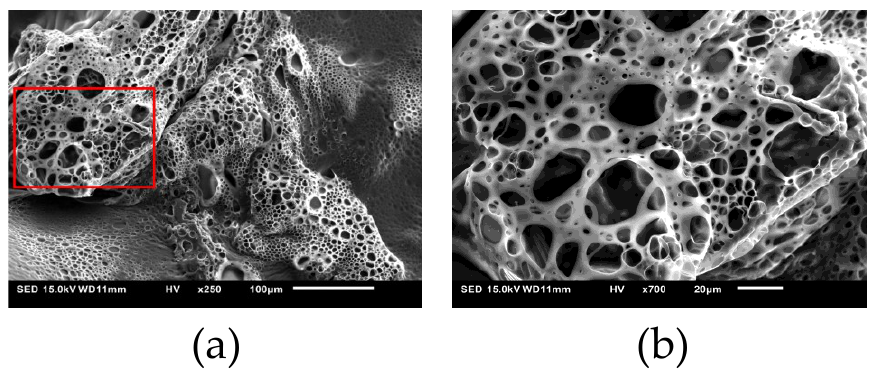
Figure 13. SEM of a PSt- l -VBzGG-3 1 wt% gel swollen in CHCl 3 . ( a ) Sample at 250× magnification; ( b ) red-framed area in image ( a ) observed at 1100× magnification. See ‘Materials and Methods’ for analysis conditions.